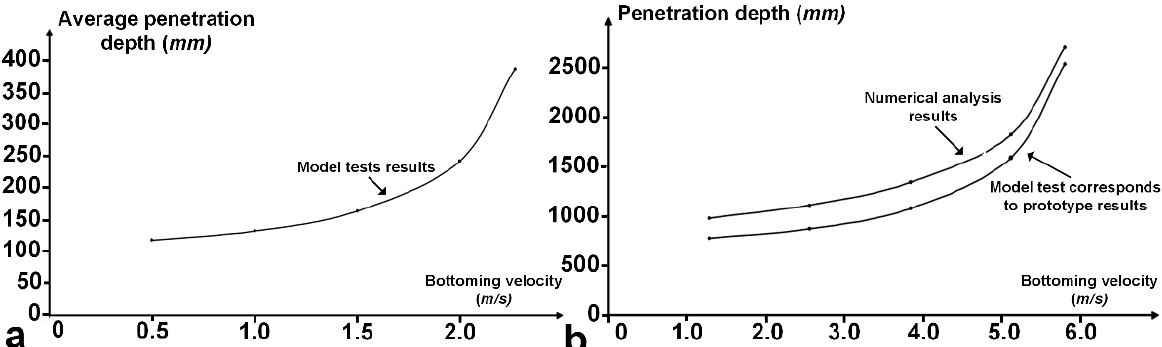
Figure 13. The penetration depth versus bottoming velocity of the anchor. ( a ) The results in the model test ( b ) The simulation results and the prototype results.